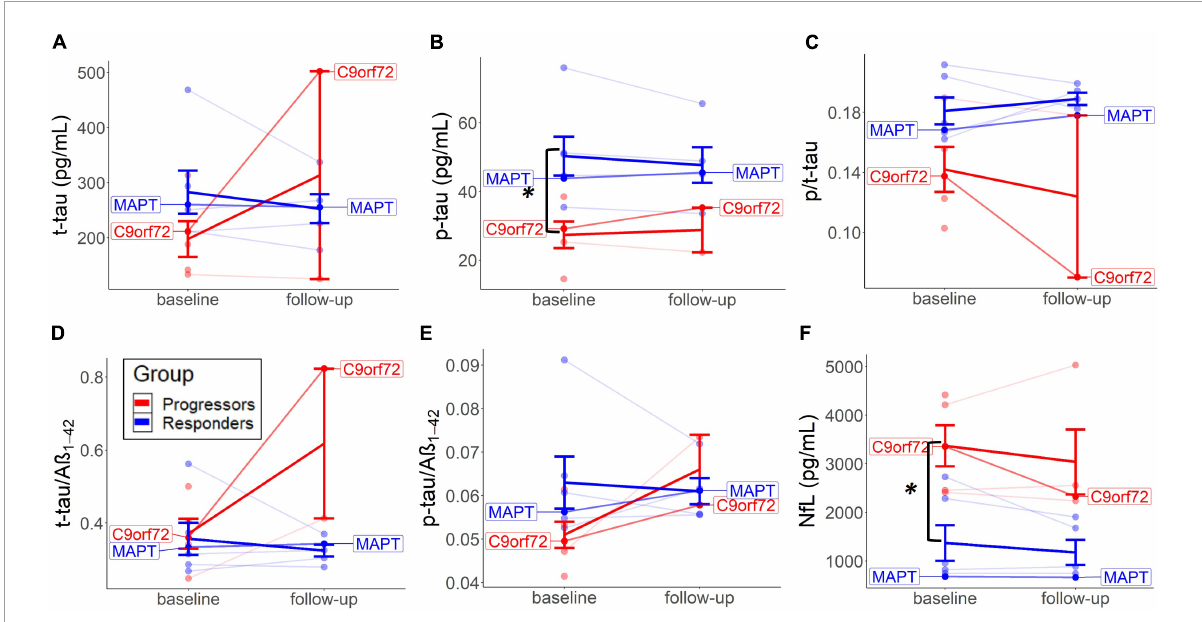
FIGURE3 Baseline and long-term CSF change in each group. Changes from baseline to follow-up on the individual level are represented for t-tau (A) , p-tau (B) , p/t-tau (C) , t-tau/A β 1 − 42 (D) , p-tau/A β 1 − 42 (E) , and NfL levels (F) . Thick lines reflect group means. Both patients with the identified mutation are highlighted.